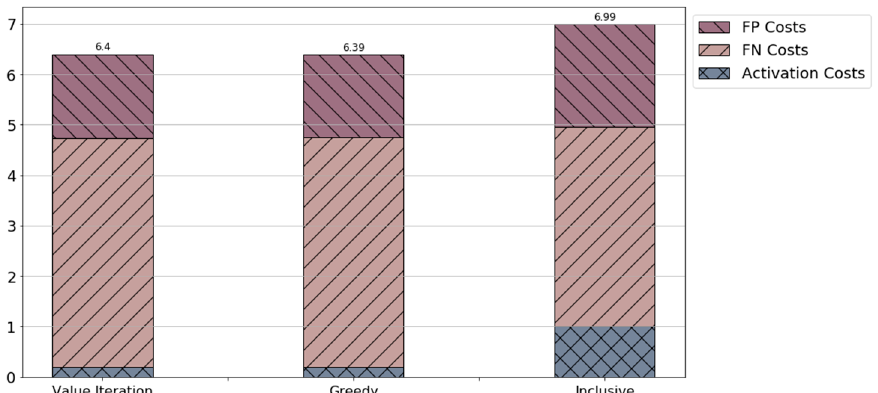
Figure 4. Activation and misclassification cost breakdown obtained by the different proposed policies. The costs are average over all patients. “FP” stands for false positive and “FN” stands for false negative.